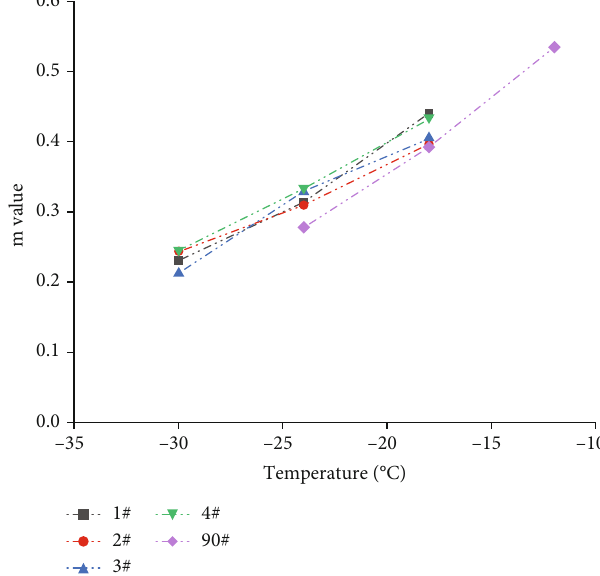
Figure 11: m value curve of tire rubber powder-modi fi ed